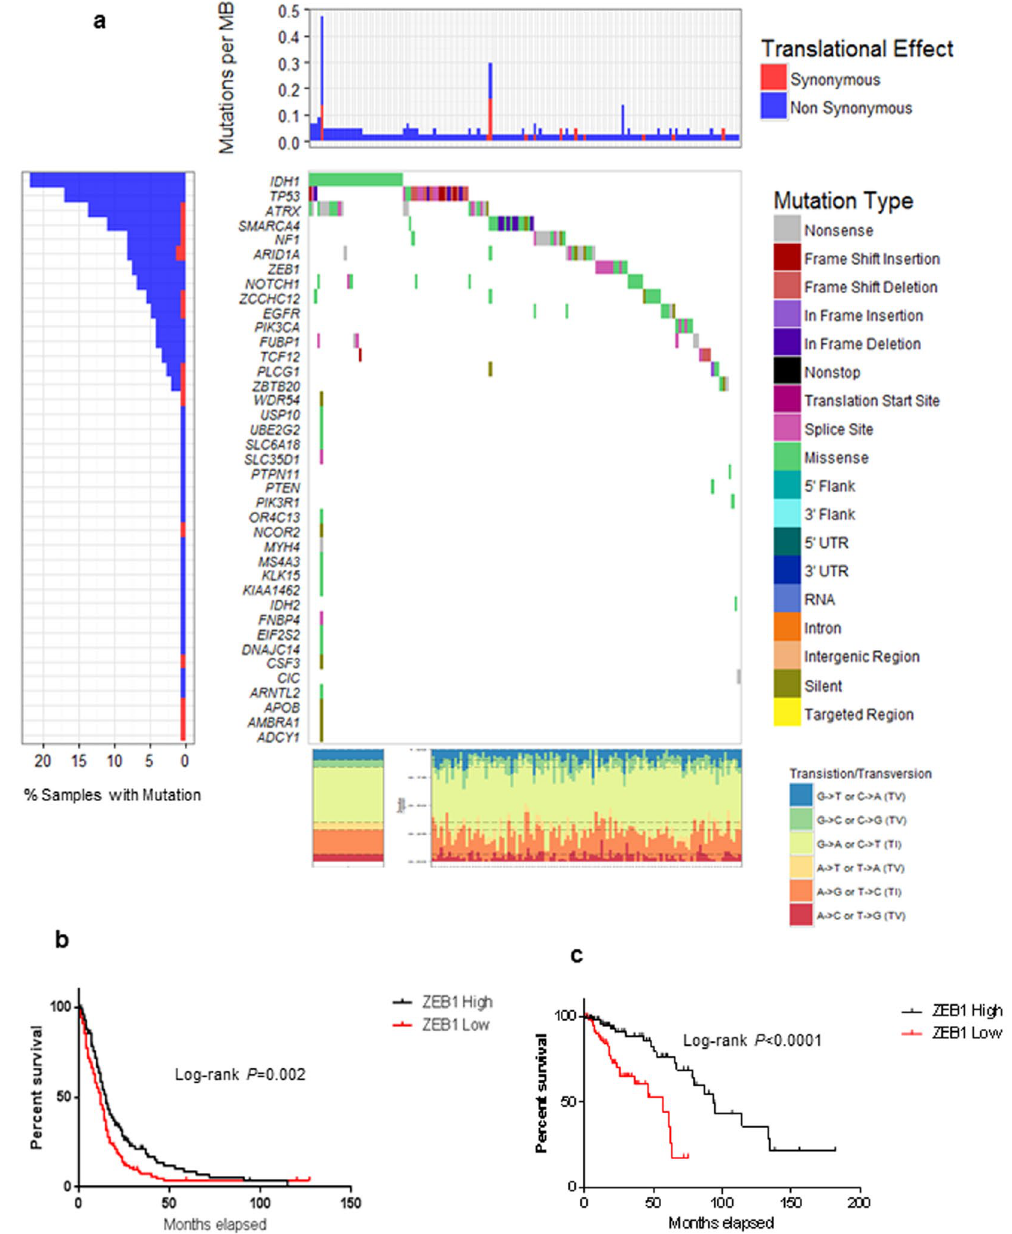
Figure 3. Genomic alterations in gliomas. ( a ) Glioma samples are arranged from left to right. Alterations of low grade gliomas and GBM candidate genes are annotated for each sample according to the color panel (right). The somatic mutation frequencies for each candidate gene are plotted on the left panel. Mutation rates and type of base-pair substitution are displayed in the top and bottom panel, respectively. ( b ) Estimated Kaplan-Meier survival curves for 507 glioblastoma patients (left) for high and low ZEB1 expression. Patients with GBMs having high vs. low ZEB1 expression had estimated median survival times of 580 vs. 310 weeks. P -value was determined by log rank test * P = 0.002, hazard ratio 1.25. ( c ) Estimated Kaplan-Meier survival curves for 249 low grade gliomas patients (right) for high and low ZEB1 expression. P -value was determined by log rank test *** P < 0.0001, hazard ratio